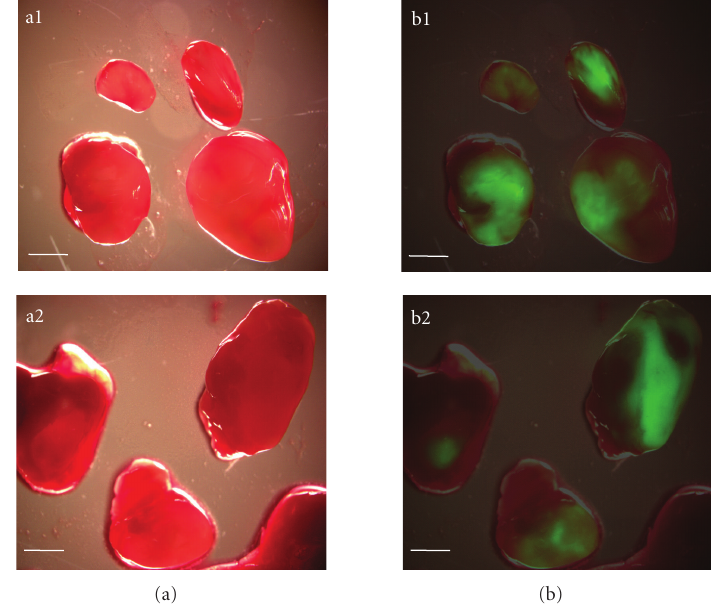
Figure 6: Detection of lymph node metastases by GLV-1h68-mediated fluorescence. (a) Bright-field, and (b) overlay fluorescence images of renal and lumbar lymph nodes in GLV-1h68-infected mice with PC-3 tumors. a1, b1: mouse no. 1 and a2, b2: mouse no. 2. Scale bars =